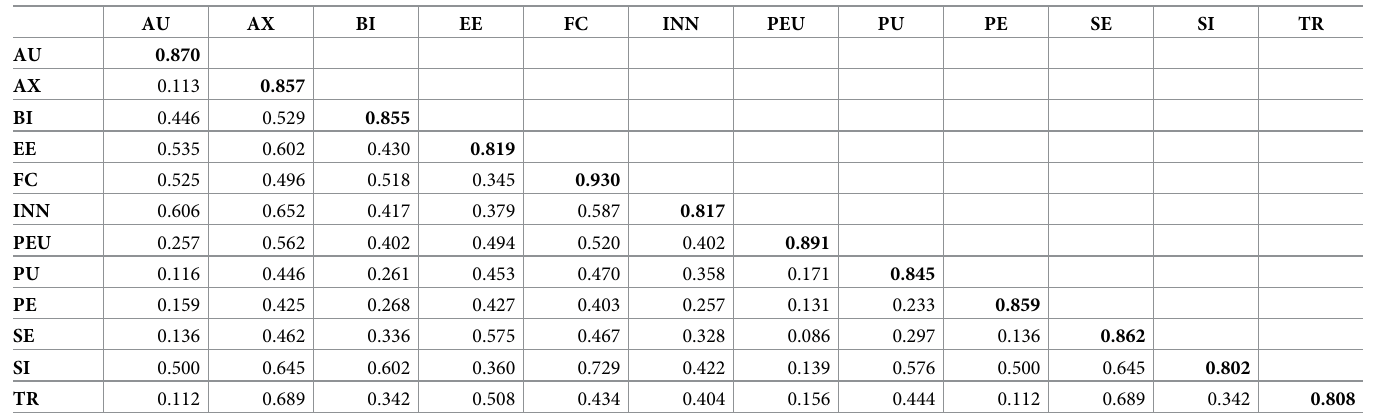
Table 4. Fornell-Larcker scale.